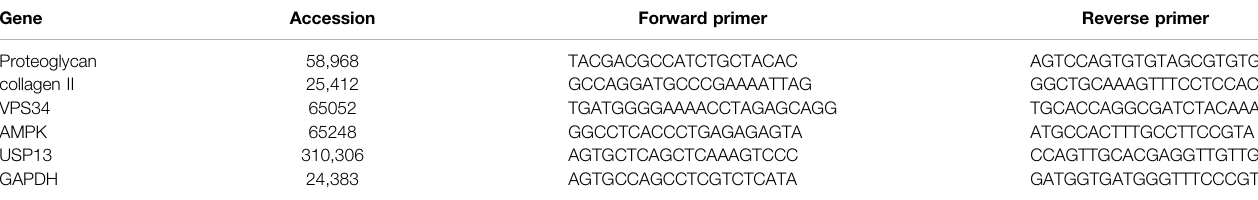
TABLE 2 | The primers for the quantitative real-time PCR. Gene